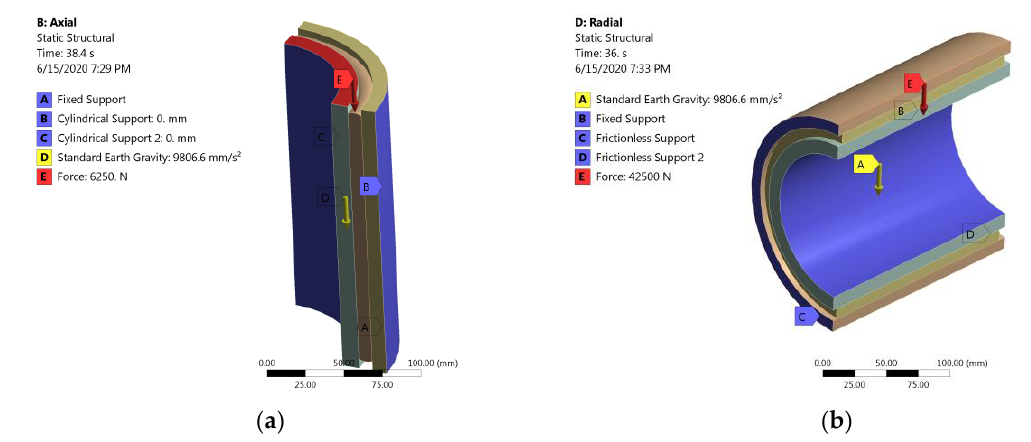
Figure 3. Finite element model and load and boundary conditions for axial ( a ) and radial ( b ) load cases.